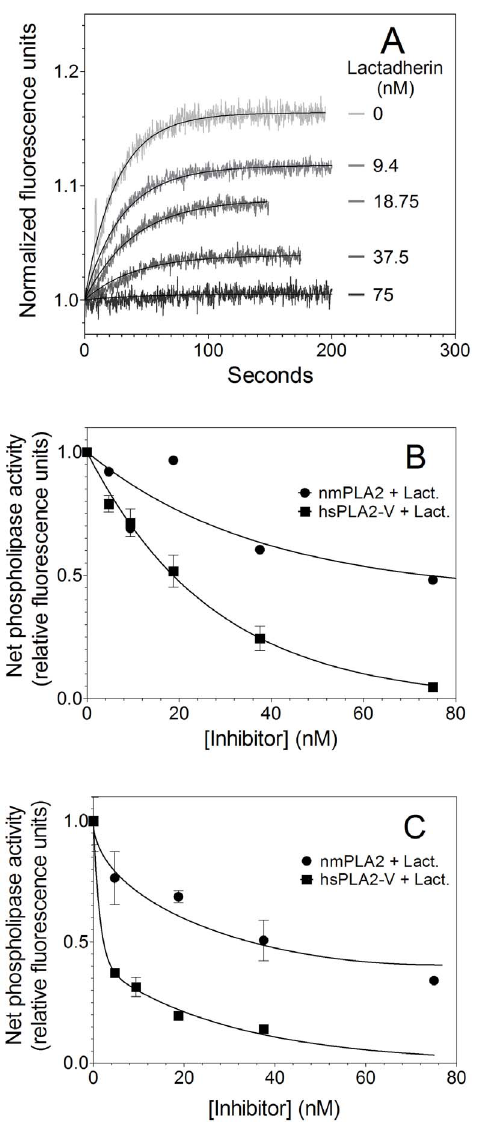
Figure 3. Lactadherin inhibition of hsPLA 2 vs. nmPLA 2 . ( A ) Various concentrations of lactadherin were added to 10 m M phospho- lipid vesicles with composition as described for Fig. 2. Phospholipid vesicles were preincubated for 15 minutes with bovine lactadherin before transfer to a quartz cuvette and cooling for 5 minutes at 4 u C. hsPLA 2 -V was added to a final concentration of 0.06 U/ml and the activity monitored continuously as fluorescence emission at 515 nm. Data were fitted to a double exponential model and fitted globally as described in Fig. 2. Addition of lactadherin diminished both compo- nents of enzyme activity. ( B ) Normalized net phospholipase activity on sonicated PLVs after 400 s 6 SD are plotted as a function of lactadherin concentration with uninhibited Y max total as reference. ( C ) Experiments like those in panel 3A were performed utilizing extruded PLV rather than sonicated vesicles (not shown). Normalized phospholipase activity after 400 s 6 SD are plotted as function of lactadherin concentration. As seen in all panels, the PS sensitive hsPLA 2 -V is more readily blocked by lactadherin. All experiments were performed at least twice and results averaged for data displayed in panels B and C.